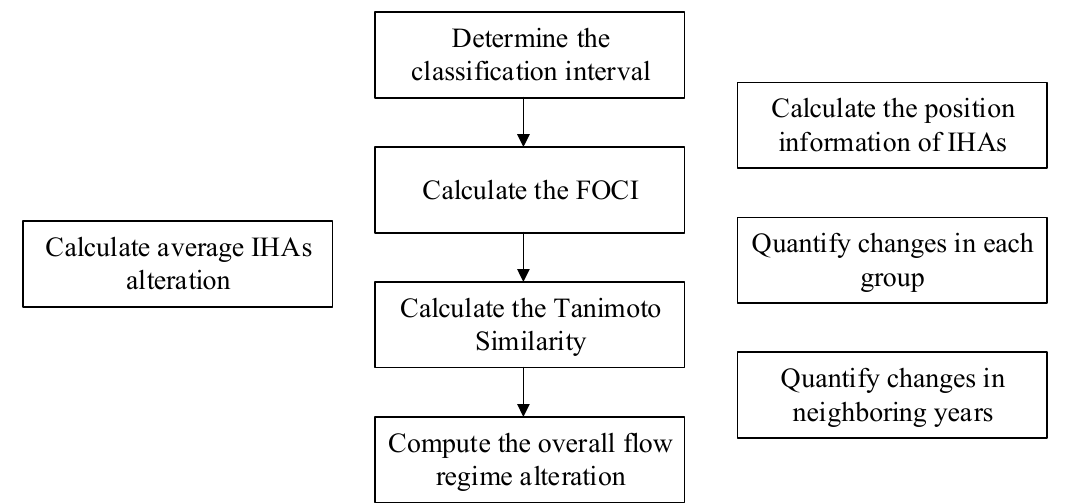
Figure 2. Flow chart of the methodology adopted in this study. The left side shows the single step in the traditional RVA, while the right-hand boxes show the novel steps in the current study.